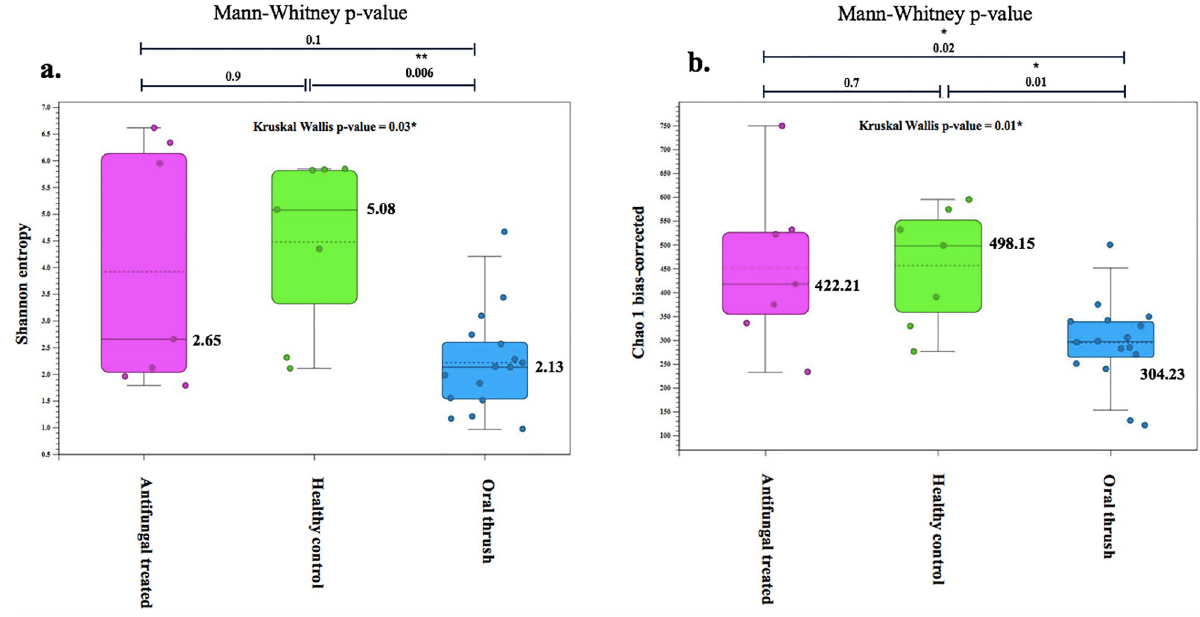
Fig 1. Box plots depicting alpha diversity measures for each study group (AT, HC, and OT). (a) Shannon entropy and (b) Chao-1 biased corrected analysis. The different colors represent the oral thrush status of participants.